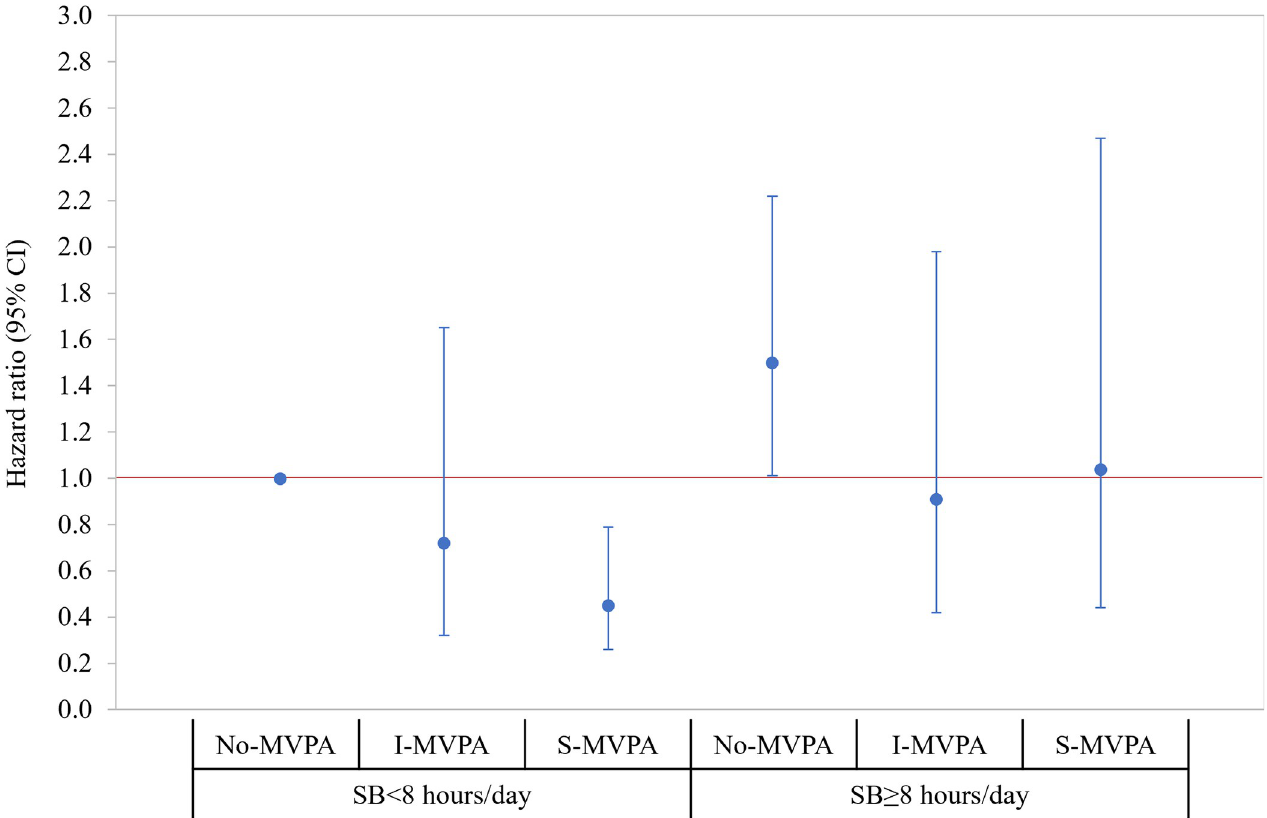
Fig 1. Joint association where HF patients with SB < 8 hours/day associated with inactive (no-MVPA) were a reference group. Hazard ratios (95% CI) were estimated from the Cox proportional hazard regression model adjusting the study covariates retained using the backward elimination approach ( P < .20), which include age group, race/ethnicity, education, BMI group, marital status, and self-reported medical conditions (coronary heart disease, high cholesterol, and diabetes), and walking difficulty score. The estimated parameters presented in the figures are reported in Online Supplemental Table 4 in S1 File . CI = confidence interval; SB = sedentary behavior; I-MVPA = insufficient moderate-vigorous-intensity physical activity (MVPA minute/week between 0 and 150); S-MVPA = sufficient moderate- and vigorous-intensity physical activity ( � 150 minutes/week of MVPA).